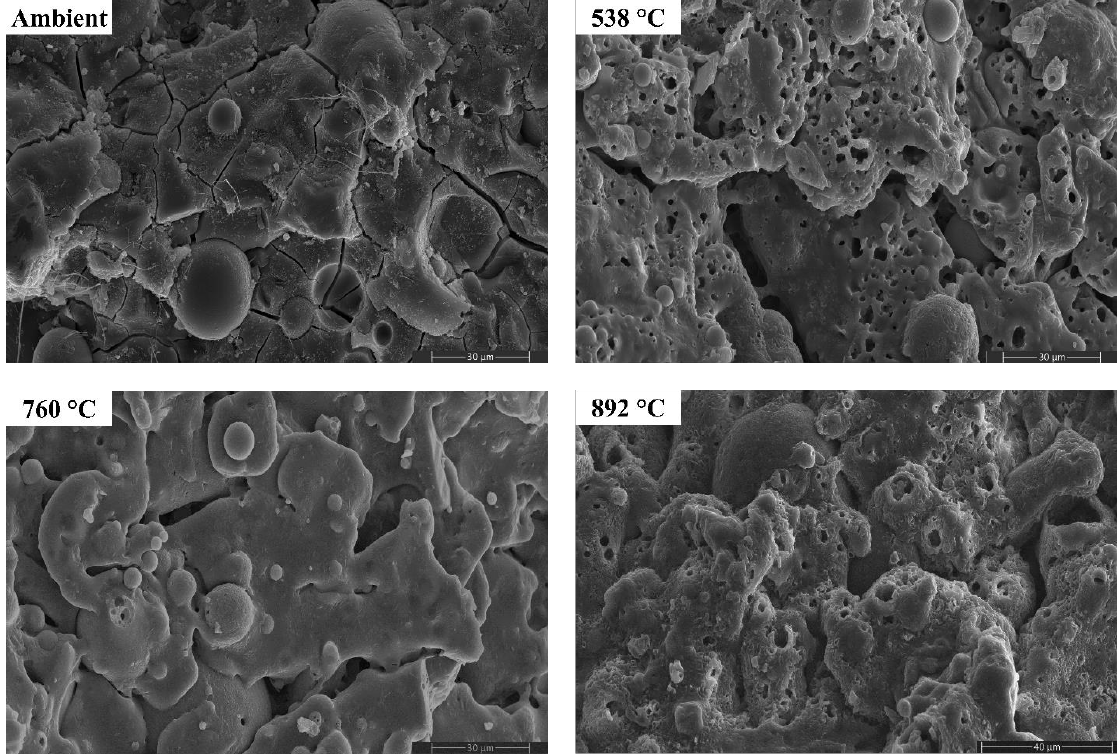
Figure 18. SEM micrographs of FS 50P-1.4 exposed to high temperatures.